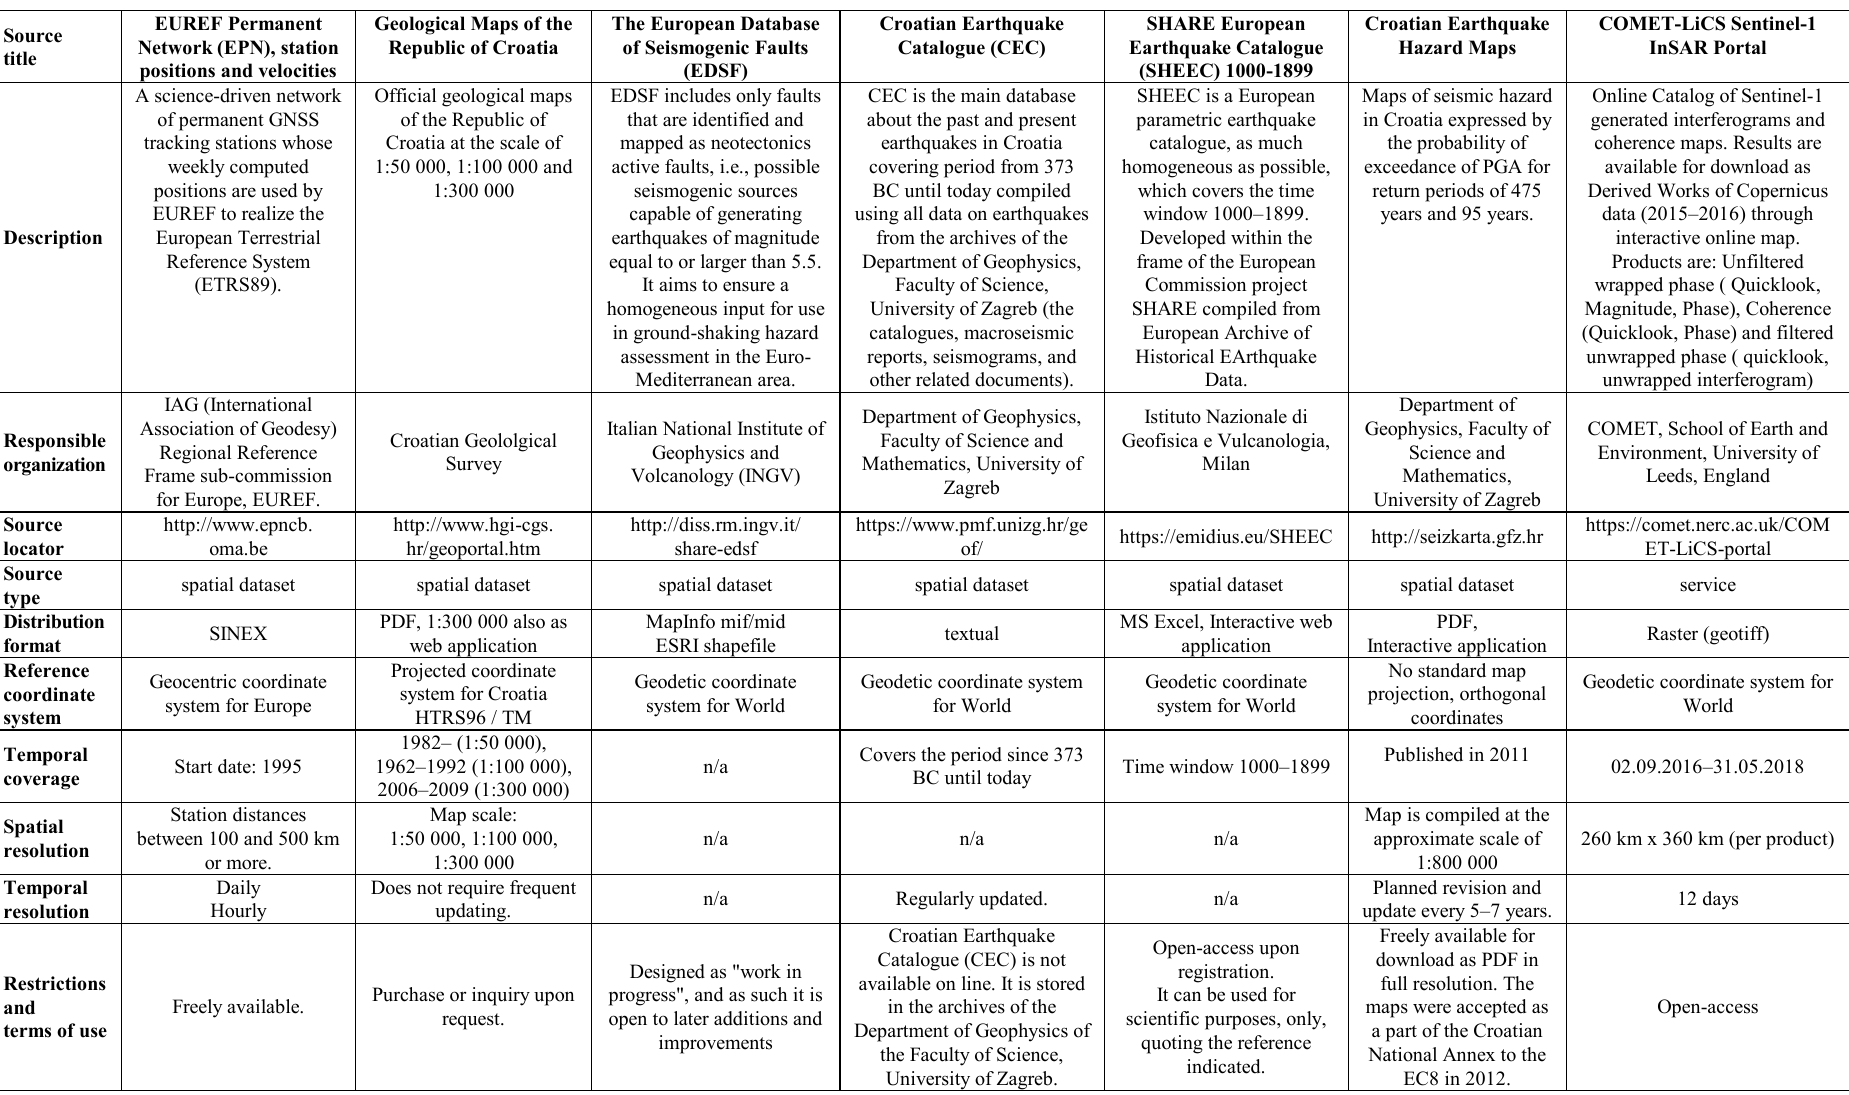
Table 1. Overview of the availability, scale, precision and usage of the possible sources of geoinformation that could be used to address the current knowledge on ongoing geodynamic processes in the Republic of Croatia